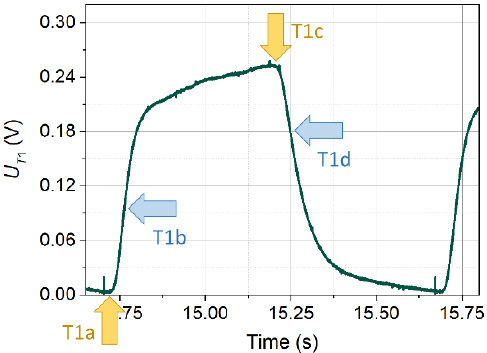
Figure 9. Selected characteristic points of signals from the detectors, using the example of the signal from detector T1 for the inflow velocity v ∞ = 0.065 m/s and the wave frequency f = 1.0 Hz.